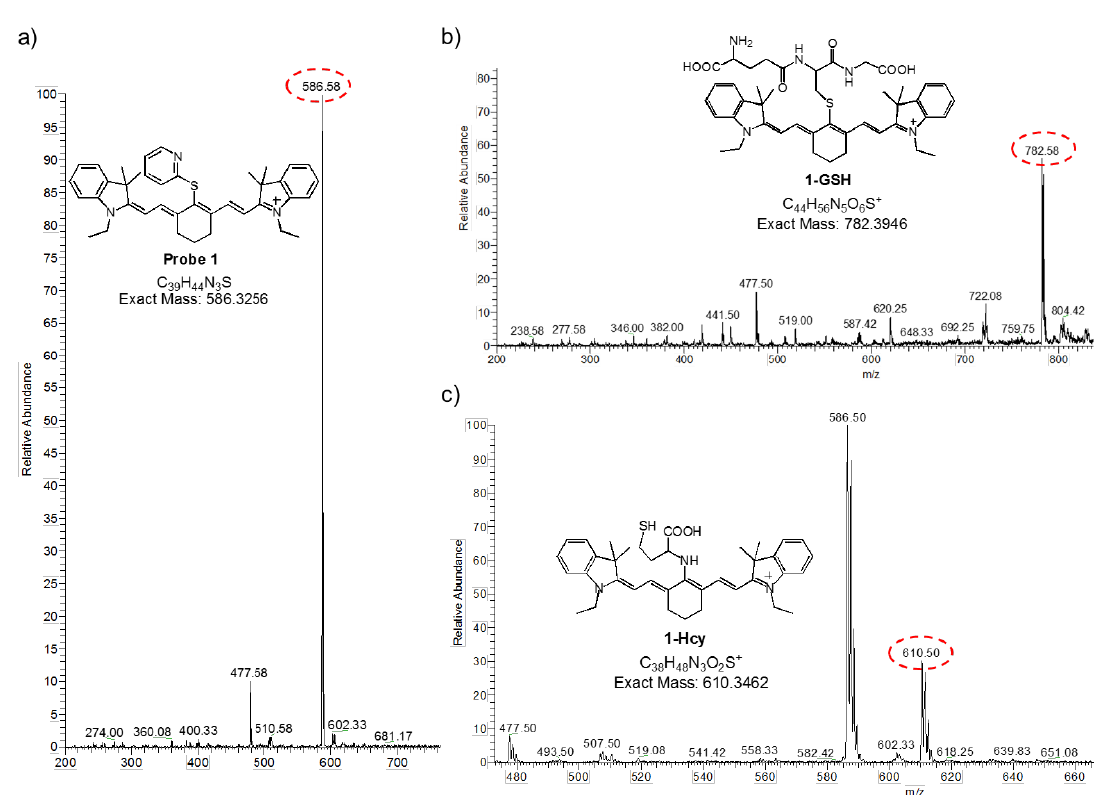
Figure 3. ESI-MS spectra of 1 ( a ) in the absence and presence of ( b ) GSH or ( c ) Hcy.